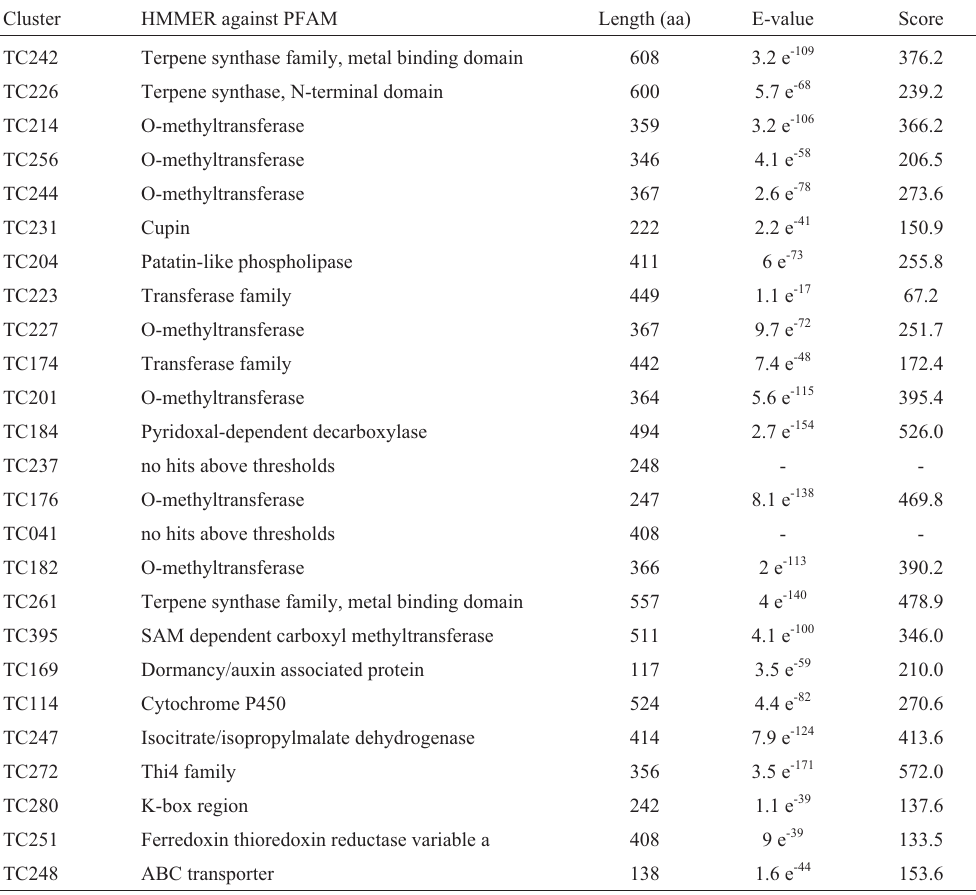
Table 2 - Flavedo differentially expressed sequences, putative flavedo-specific and -enriched genes: PFAM